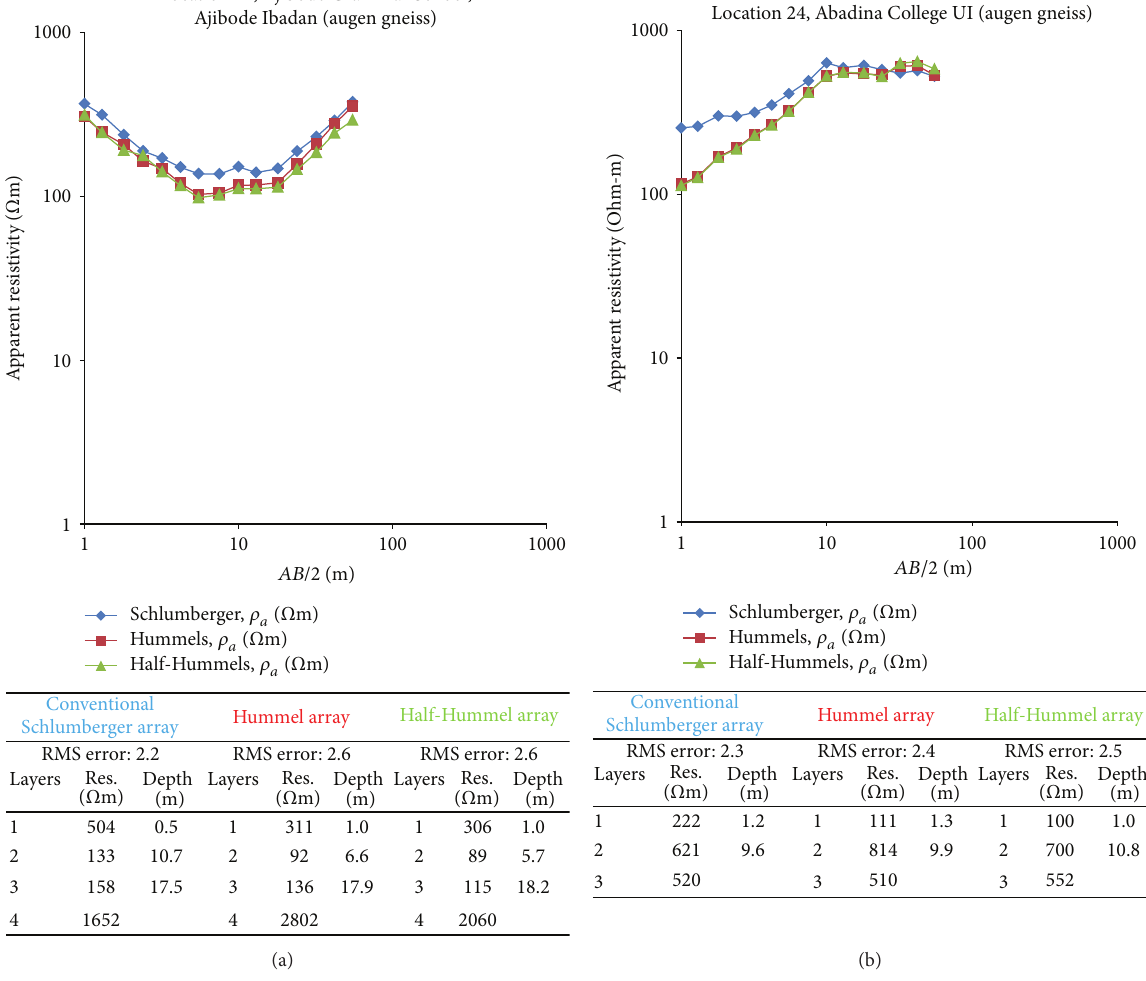
Figure 17: Comparison of results obtained from the interpretation of field data collected using the different array methods at VES stations on augen gneiss for (a) location 22, Ajibode Ibadan, and (b) location 24, Ajibode